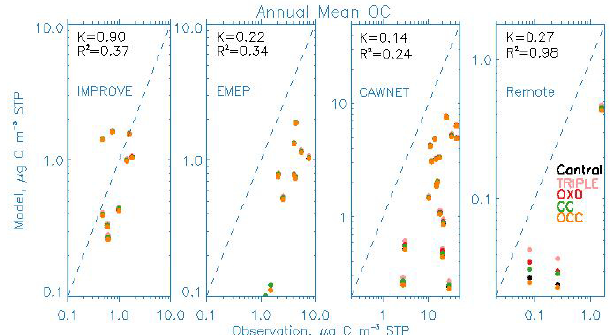
Fig. 9b. Same as Fig. 9a but for